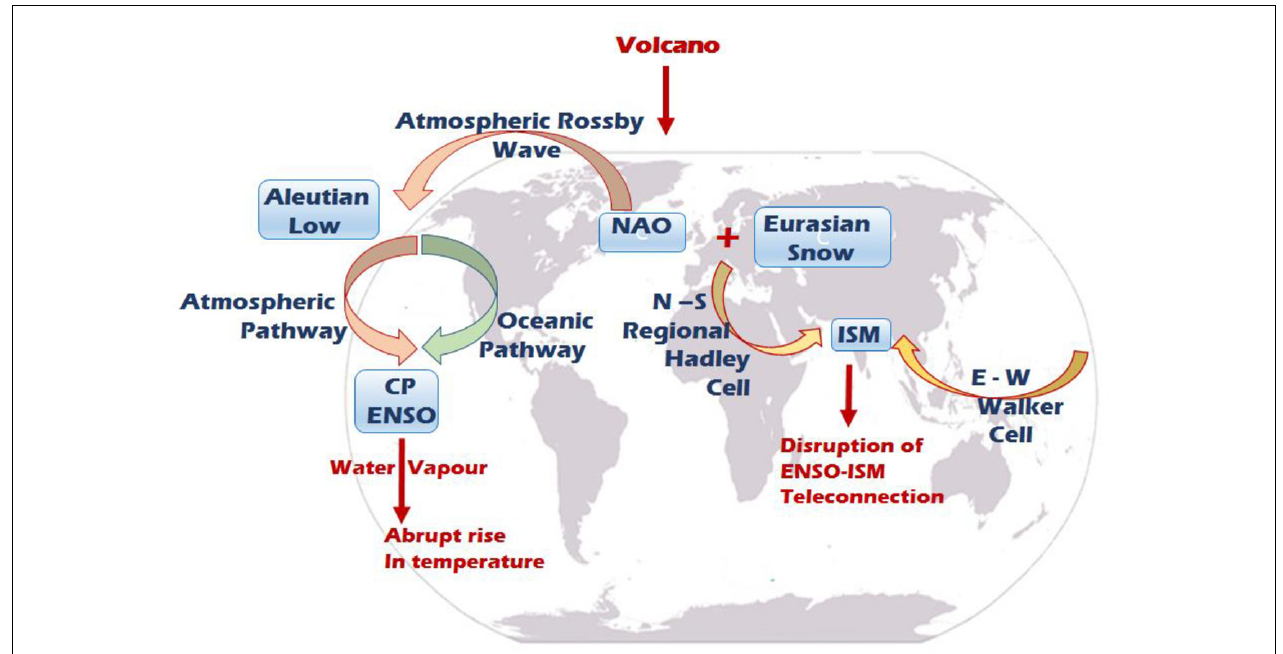
FIGURE 13 | A schematic of mechanisms initiated by explosive volcanism during 1976–1996. It modulates various modes (NAO, ISM and CP ENSO) and influences various places (AL and Eurasian snow cover), shown by blue box. AL is impacted from North Atlantic via Atmospheric Rossby waves. That signal is transported to trigger CP ENSO via Atmospheric (pink arrow) and Oceanic pathways (green arrow). CP ENSO increases atmospheric water vapor causing abrupt rise in global temperature (shown by red). Combination of NAO and Eurasian Snow strongly modulate regional N-S Hadley circulation (yellow arrow) to impact ISM. Usual ENSO-ISM teleconnection via E-W Walker circulation (yellow arrow) is thus overtaken suggesting a disruption in ENSO-ISM teleconnection (shown by